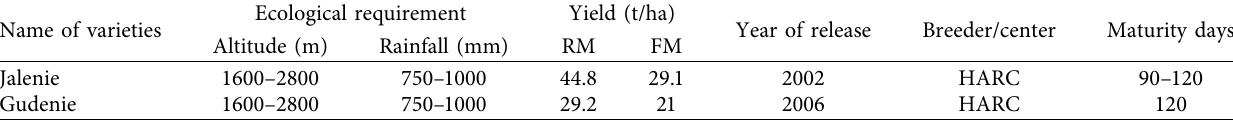
Table 1: Description of varieties